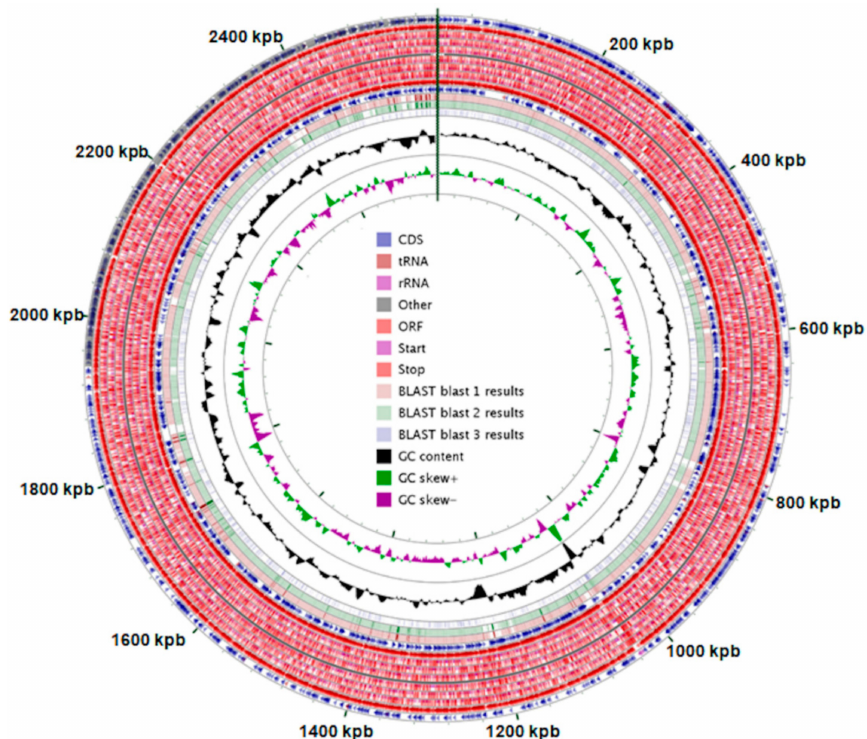
Figure 1. Genome properties of Propionibacterium freudenreichii ssp. freudenreichii T82 (in original size—Figure S11). Blast 1—Propionibacterium freudenreichii subsp. shermanii CIRM-BIA1, Blast